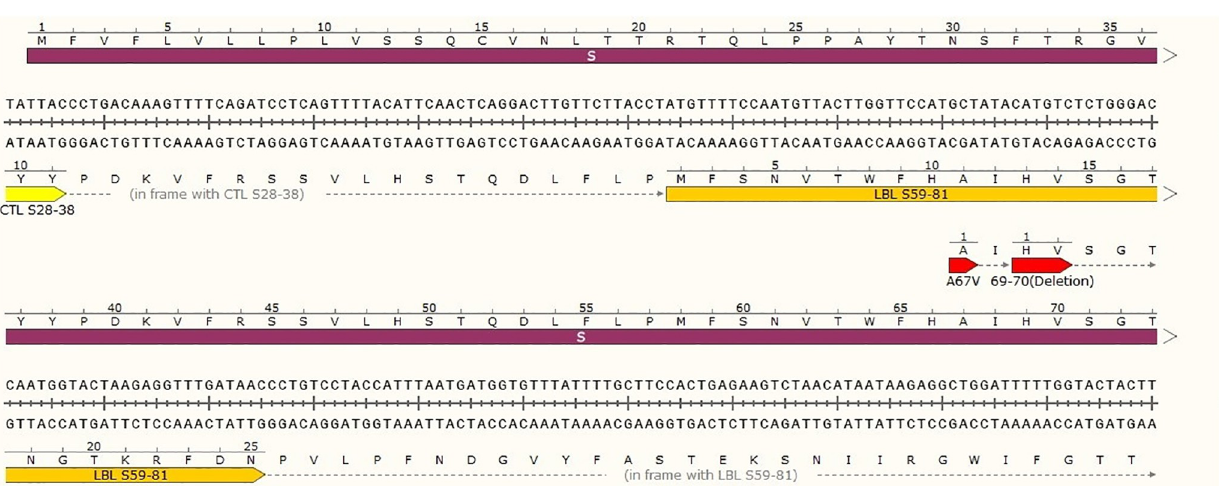
Fig 4. Mutation of SARS-CoV-2 delta and omicron strains in S protein of the virus. Of the twelve selected epitopes, only LBL S 59-81 epitope contained mutation. The mutation was shown in yellow containing a substitution and two deletions.